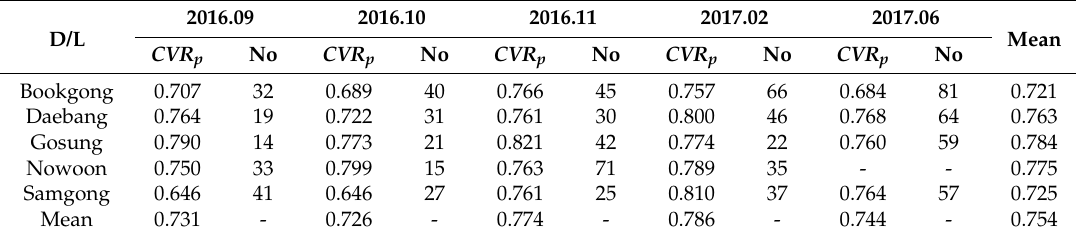
Table 5. CVR factors for the active power of the Chimsan substation (MAD direct method). D/L